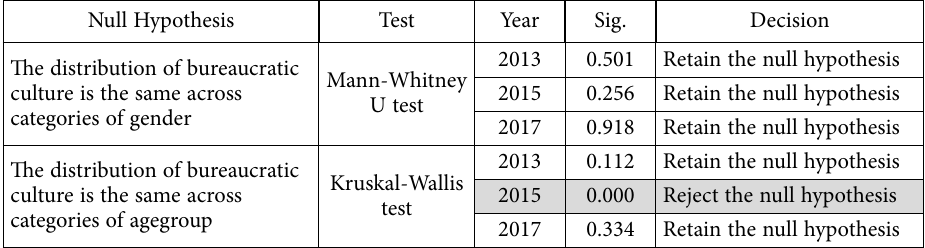
Table 4. Hypotheses verification – bureaucratic culture (source: Prepared by the authors) Null Hypothesis Test Year Sig.